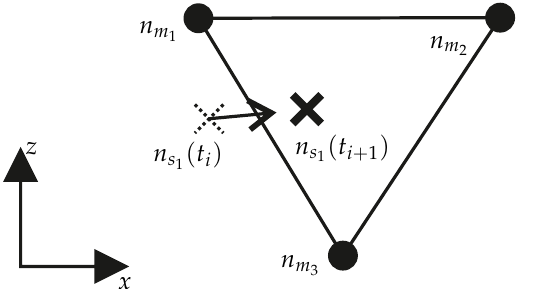
Figure 10. The node n s is located at time t i + 1 on a triangular area which is defined by the nodes 1 ∀ k ∈ M = n m n m of the master 1 1 − 3 k